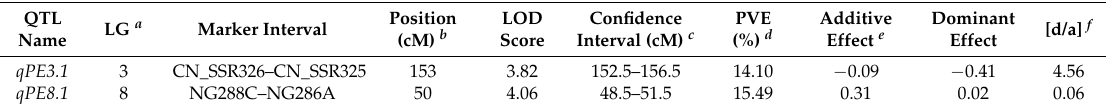
Table 2. Locations and genetic effects of quantitative trait loci (QTLs) detected for seed phorbol esters content in the F 2 population of Chai Nat × M10 by inclusive composite interval mapping.